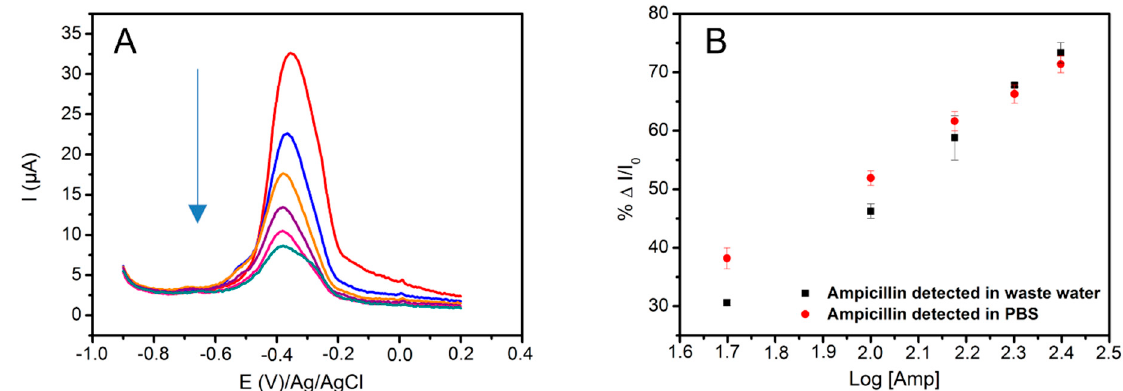
Figure 8. ( A ) SWV showing the oxidation peak of the biosensor after the incubation at various ampicillin concentrations 50,100, 150, 200, and 250 pg/L in river water. ( B ) Calibration curve of the biosensor displaying the relative changes in the current peak % ∆ I/I0 vs. Log [AMP] for ampicillin detection in river water (Black) and in PBS (Red).